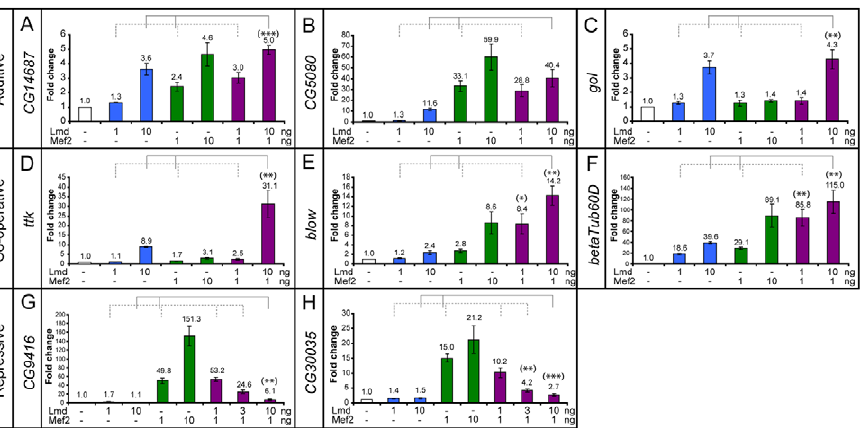
Figure 5. Different modes of co-regulation by Lmd and Mef2 invitro . Minimal regions required for Firefly luciferase reporter activity in vitro were identified in the (A) CG14687 , (B) CG5080 , (C) gol , (D) ttk , (E) blow , (F) b Tub60D , (G) CG9416 and (H) CG30035 enhancers which were cloned and assayed for activity in vitro . Expression plasmids encoding for Lmd or Mef2 proteins were co-transfected with the reporter plasmids and a Renilla normalization control at different concentrations (1 ng/10 ng) alone or in combination (x-axis). Dual-luciferase readout was normalized to reporter- only controls and fold changes are indicated as mean + / 2 1 standard error (at least three biological replicates, each done in triplicate). Informative combinations of transcription factor transfections are indicated (brackets). (A–C) Both Lmd and Mef2 can activate the CG14687 , CG5080 and gol reporters. Co-transfection of both transcription factors leads to roughly additive fold changes (brackets). (D–F) Presence of both Lmd and Mef2 yields higher activity from the ttk , blow and Tub60D enhancers than expected by summing the individual fold changes (brackets), indicating cooperative regulation. (G, H) The CG9416 and CG30035 reporters can readily be activated by Mef2, but show reduced activity upon co-transfection with Lmd, revealing its inhibitory influence in this context. The regulatory interactions are highly significant (unpaired, two-tailed student 9 s t-test, (*) p , 0.05, (**) p , 0.01, (***) p , 0.001).